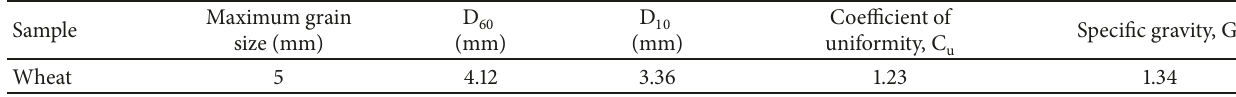
Table 1: Physical properties of wheat.